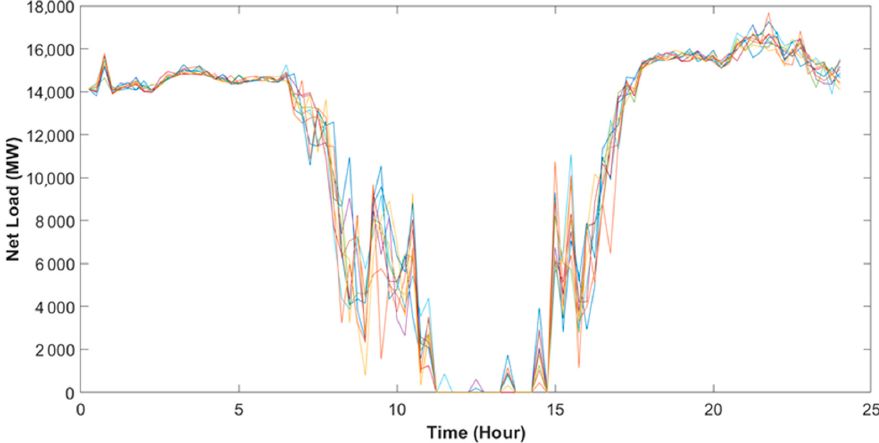
Figure 12. Renewable energy variation “medium” in 10 sets of net-load scenarios in autumn.